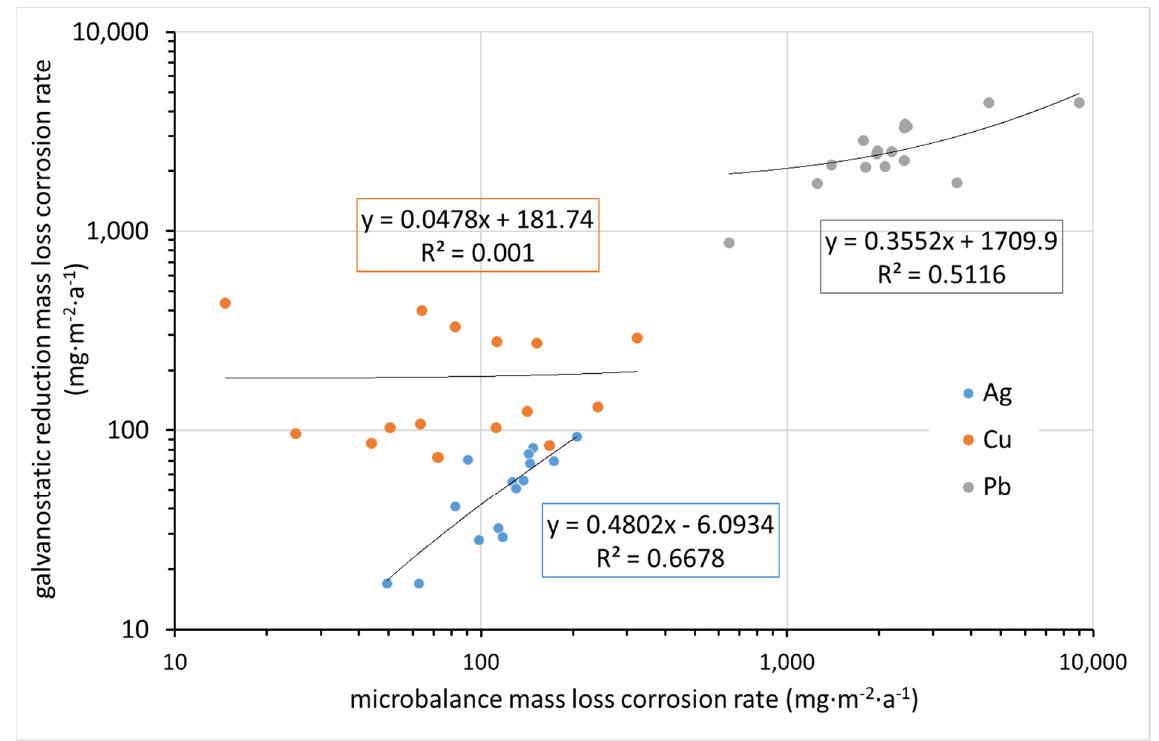
Figure 13. Comparison of corrosion rate after one year of exposure as obtained from microbalance mass loss and from electrochemical galvanostatic reduction (in regression equations, y indicates the galvanostatic reduction mass loss corrosion rate and x indicates the microbalance mass loss corrosion rate).